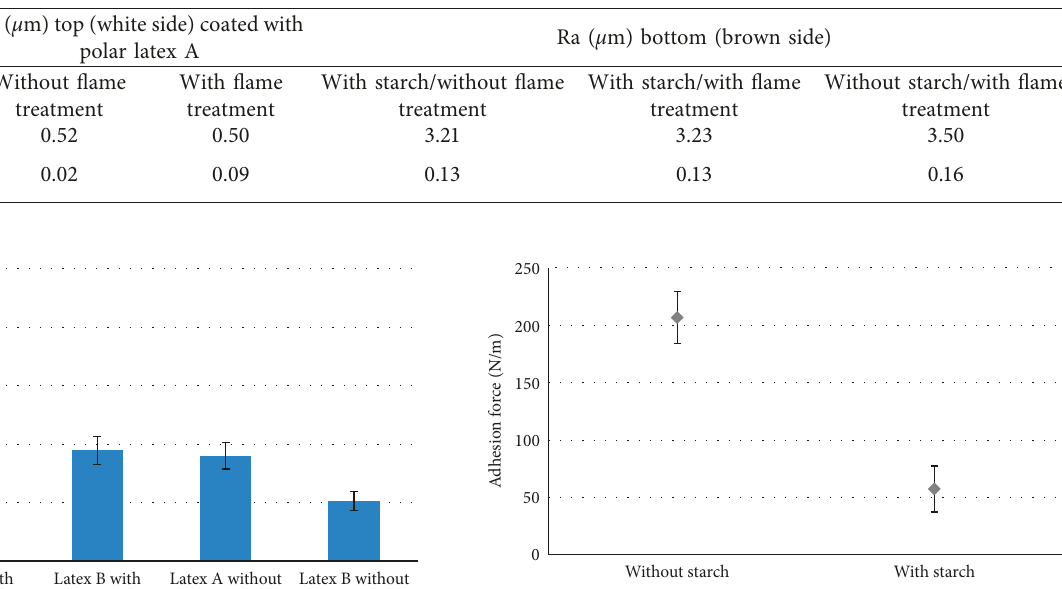
Table 1: Influence of flame treatment on roughness parameter Ra ( µ m) for the top (coated with polar latex A) and the bottom surface of the paperboard.